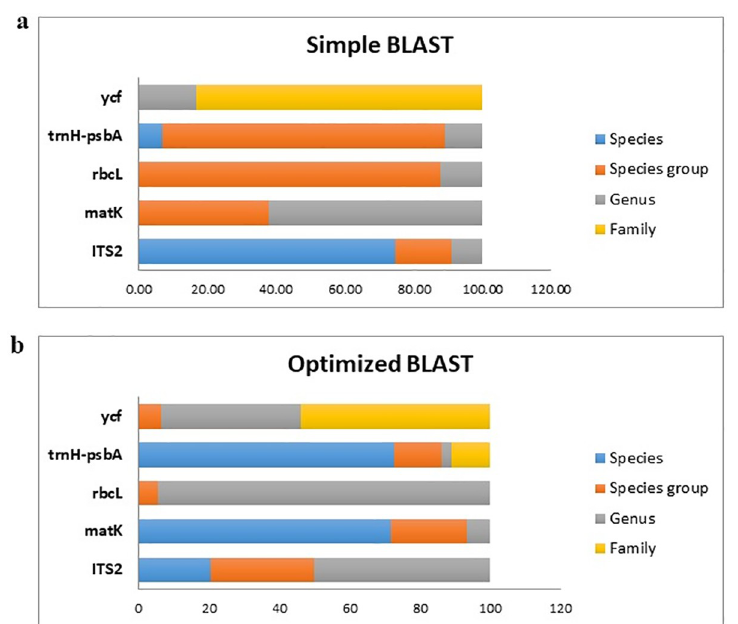
Fig 3. Comparison of DNA barcoding efficiency using selected regions; a) simple and b) optimized BLAST based on NCBI and ITS database.